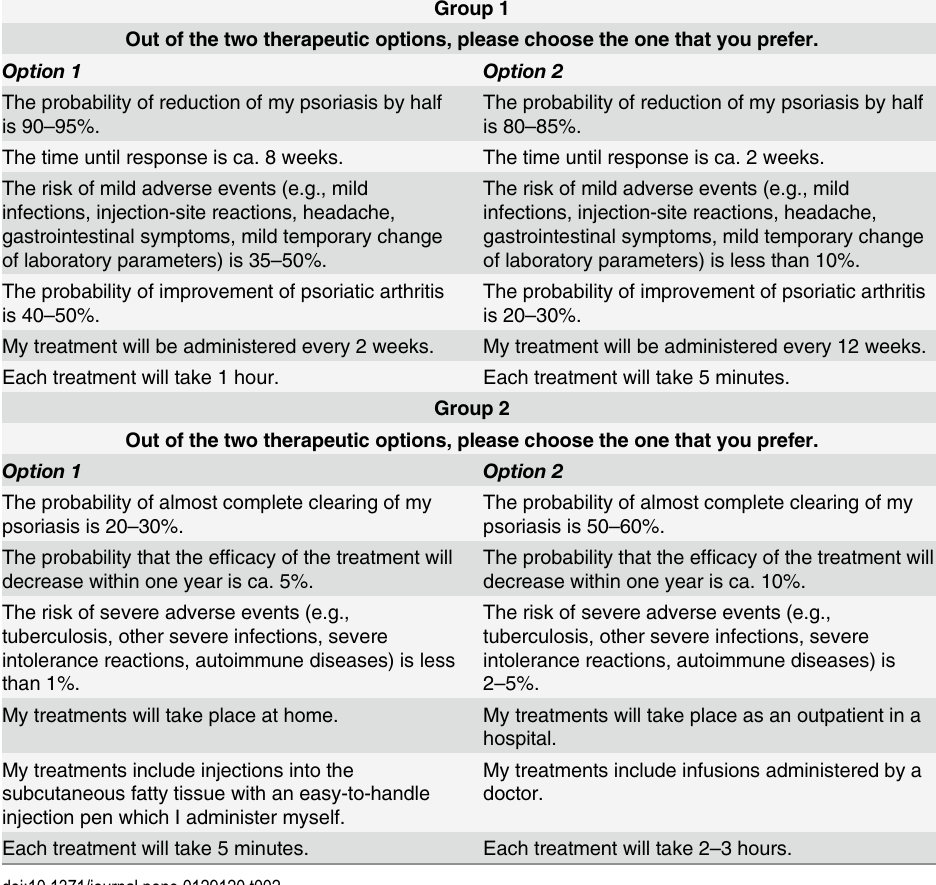
Table 2. Examples of discrete choice